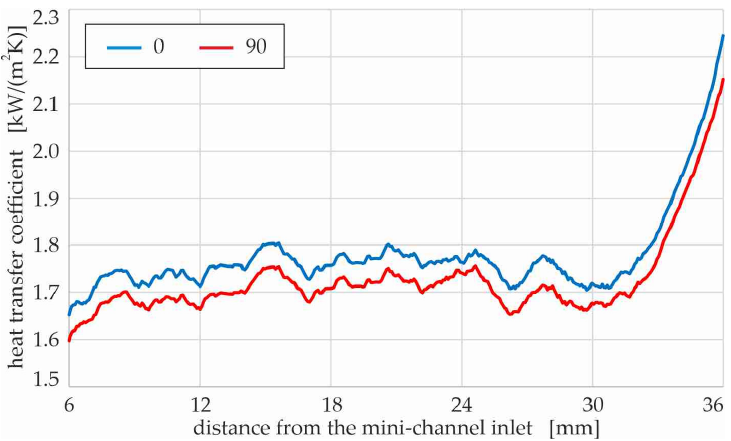
Figure 13. The heat transfer coefficient versus the distance from the mini ‐ channel inlet, assuming two spatial orientations of the test section: vertical with fluid upflow (‘90 ′ ) and horizontal with fluid flow above a heater (‘0 ′ ), as the result of numerical simulations with the aid of Simcenter STAR ‐